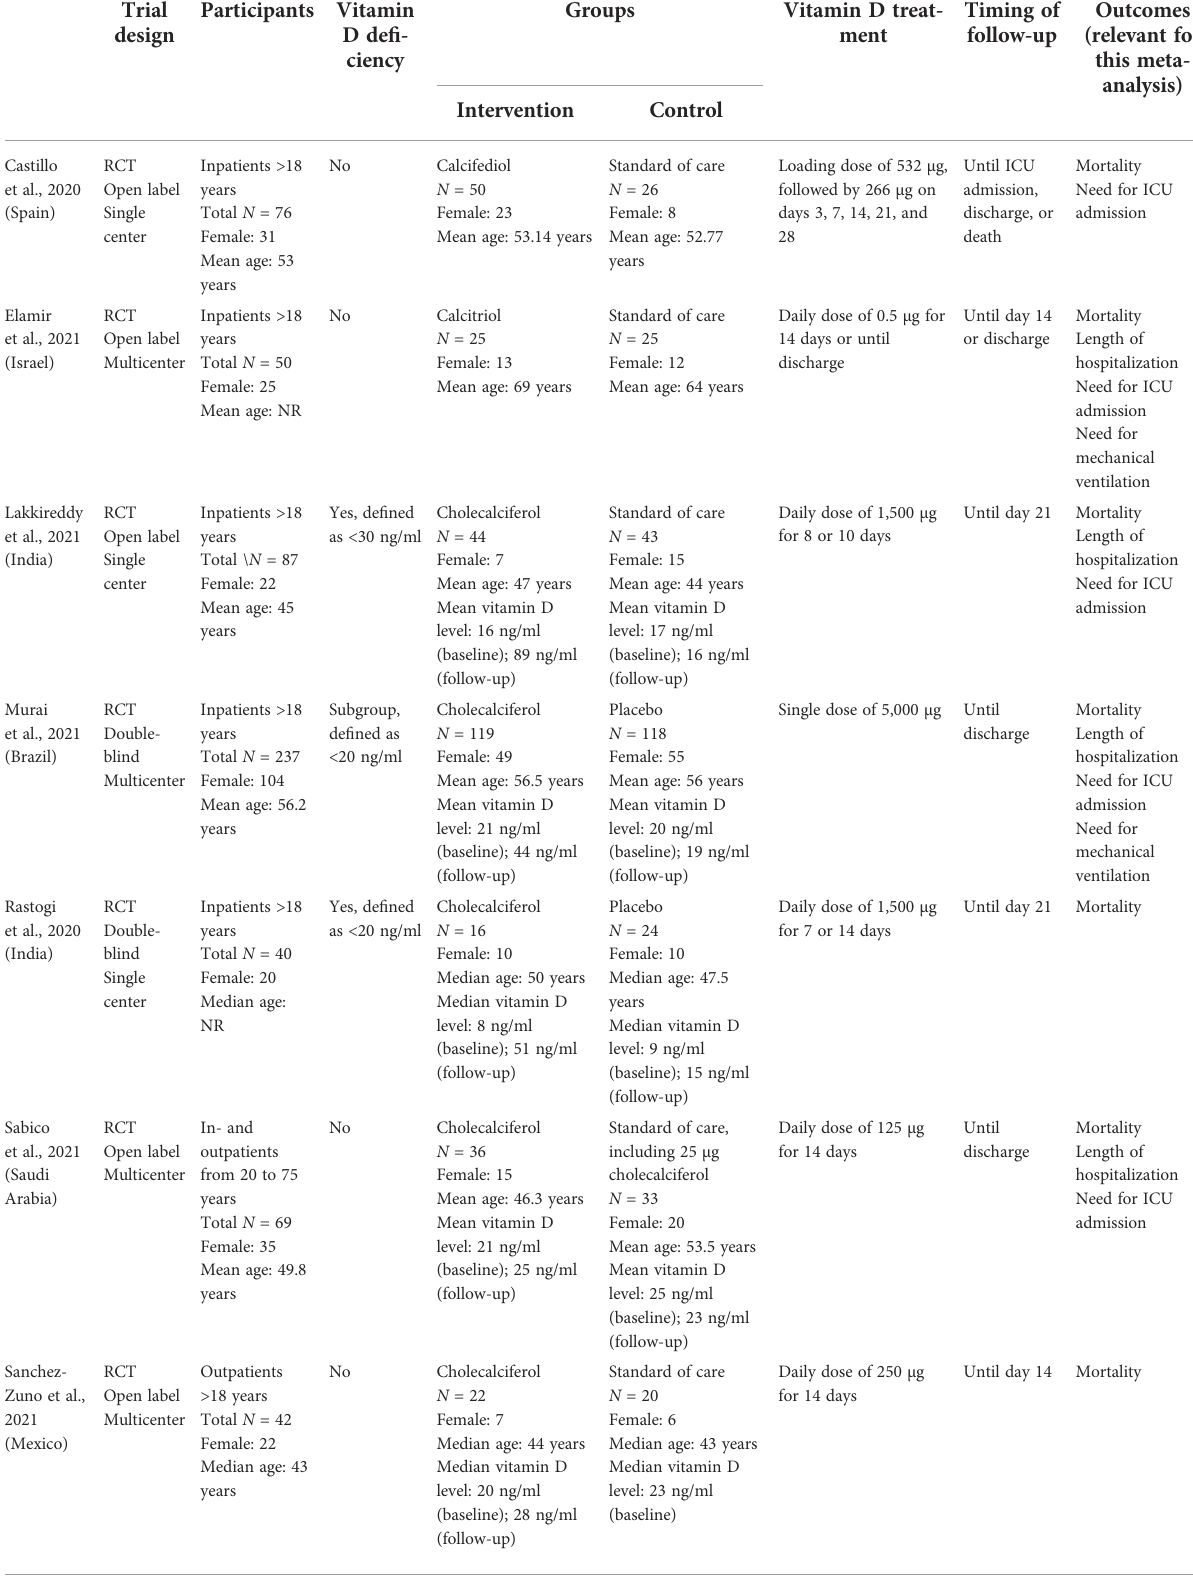
TABLE 1 Characteristics of the eligible randomized controlled trials and their patients ( 18 – 25